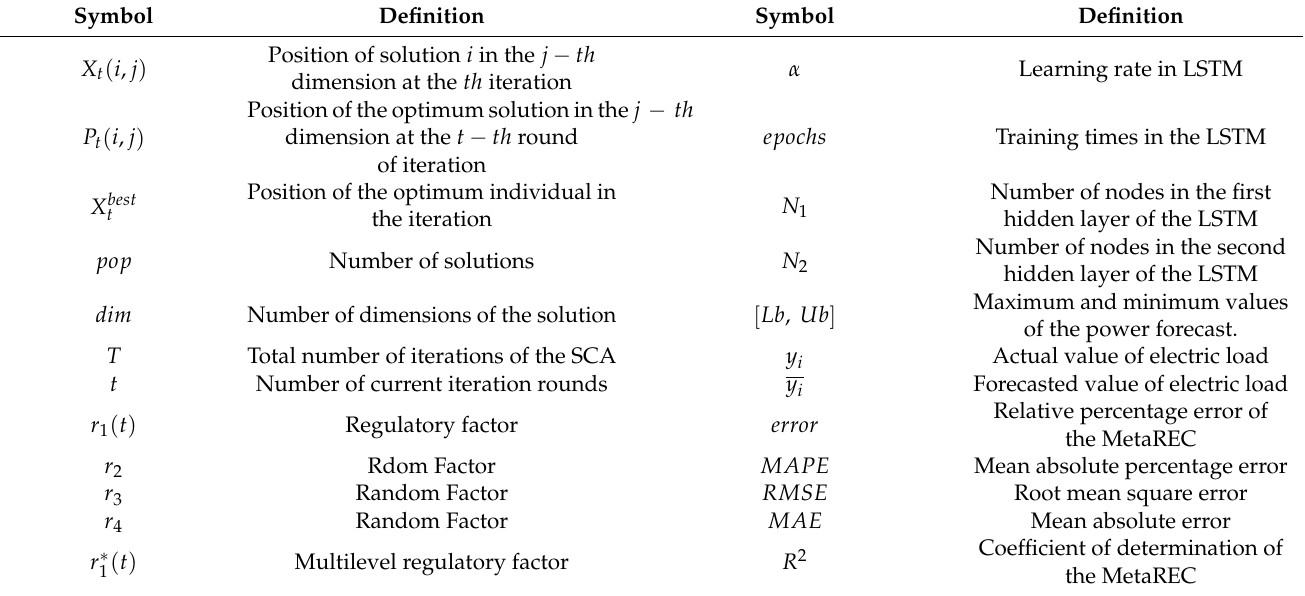
Table 1. Symbols and their